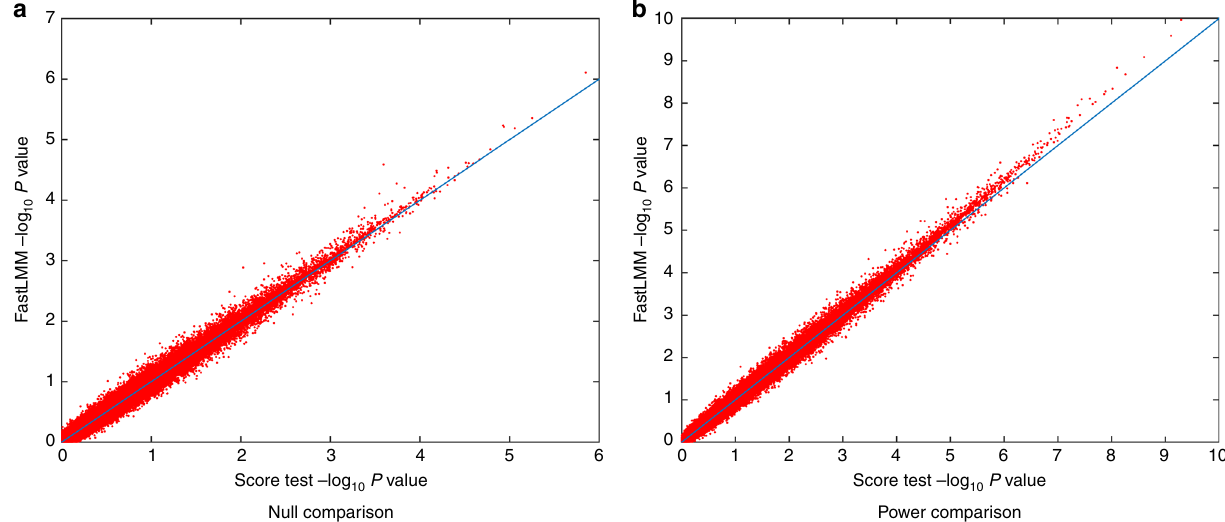
Fig. 3 Comparison of parametric P -values from FaSTLMM and the proposed method for genome-wide association analysis based on simulated data (Simulation 4). Results shown for null data ( a ) and data with signal ( b ) using FaST-LMM ’ s LRT and our score test based on one-step optimization of the simpli fi ed REML function, using 100 random markers and 5000 realizations. The overall error rates for FaST-LMM and the score test are 4.94% and 4.89%, respectively, for nominal 5%, where the Monte Carlo con fi dence interval is (4.40%,5.60%). While overall power is largely similar for both approaches (for FaST-LMM 15.25% and, and our method 15.22%), FaST-LMM is 200-fold slower